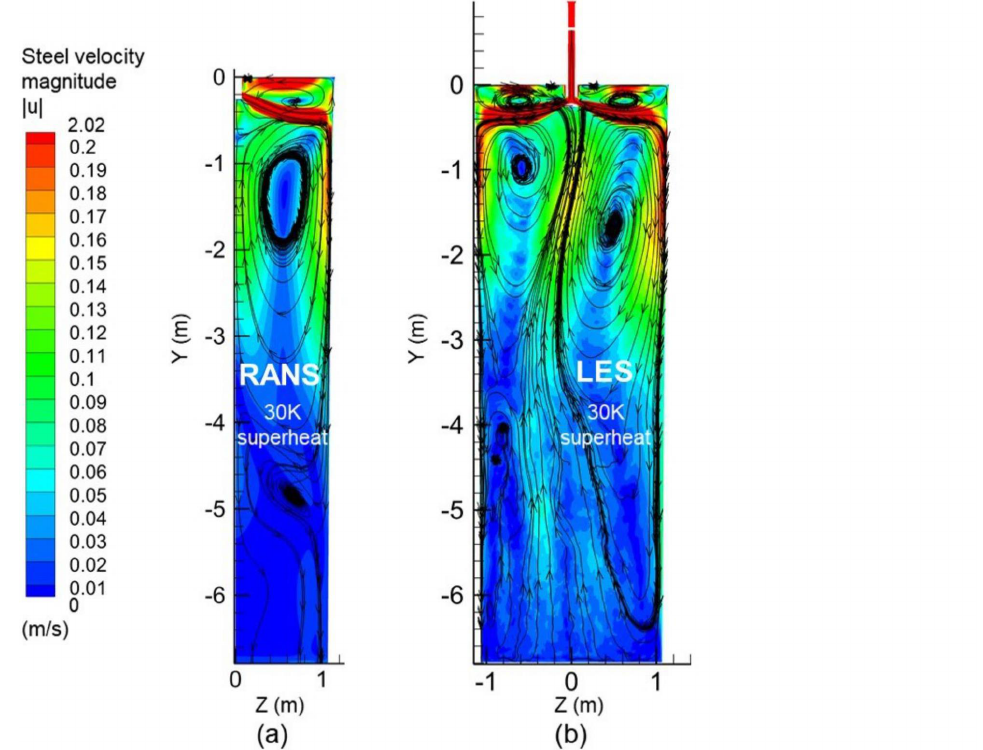
Figure 8. Fluid flow from ( a ) steady-state RANS simulation and ( b ) 38 s time-averaged LES simulation. The average residence time for molten steel to flow through the strand top surface is estimated as the half-width (1.15 m) divided by the average velocity in the upper mold (0.15 m/s), which is ∼ 8 s. Thus, 38 s should be enough to achieve an accurate time- averaged velocity near the top surface. Figure 9 compares the predicted surface velocities on a horizontal plane 10 mm below the top surface from both the RANS and the right half of LES model with nail-board measurements of the surface-flow velocity in a commercial steel plant for the same geometry and